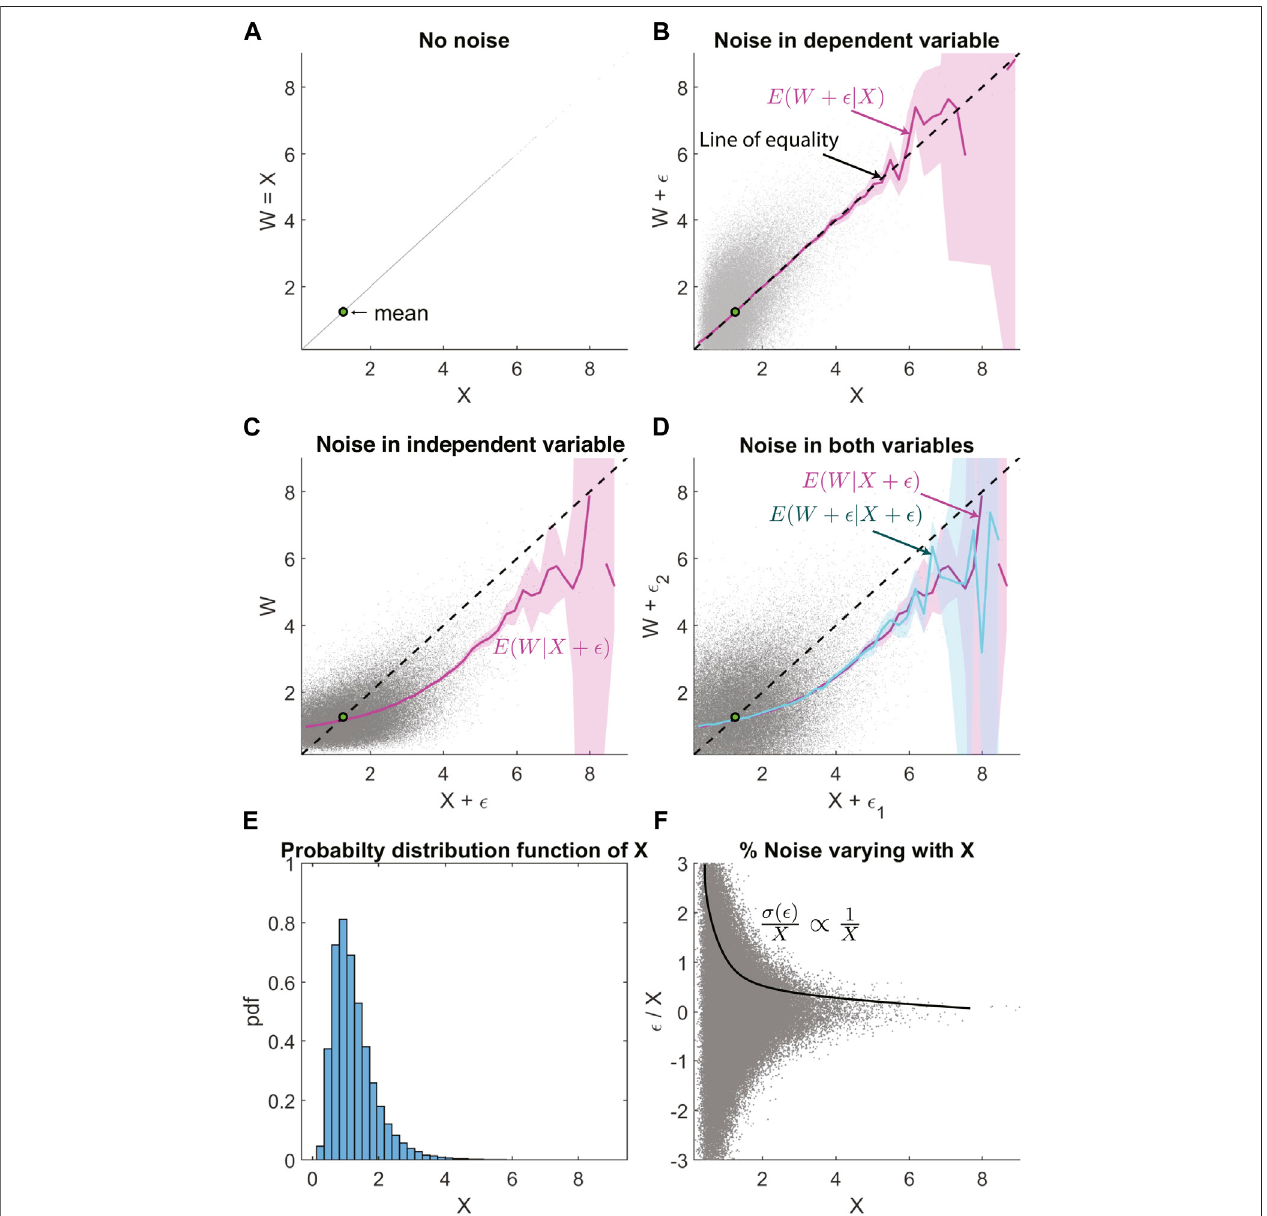
FIGURE 3 | Similar layout as Figure 1 , but with log-normal distribution and uncorrelated noise. (A) Scatter plot of W vs. X, where X is a log-normally distributed randomvariableandW=X. (B) UncorrelatedGaussiannoise ϵ isaddedto W .Magentalineshowstheconditionalexpectation E ( W + ϵ | X ).Thedashedblacklineistheline ofequality. (C) UncorrelatedGaussiannoiseaddedonlyto X ,withthemagentaline E ( W | X + ϵ )showingregressionbias. (D) UncorrelatedGaussiannoiseisaddedtoboth W and X , with regression bias in E ( W + ϵ | X + ϵ ) is visible in the cyan line. This overlaps with the magenta line that shows E ( W | X + ϵ ) for comparison. (E) Probability distribution function X showing the log-normal distribution. (F) The fractional error σ ( ϵ )/ X that is varying inversely with X , as σ ( ϵ ) = constant .